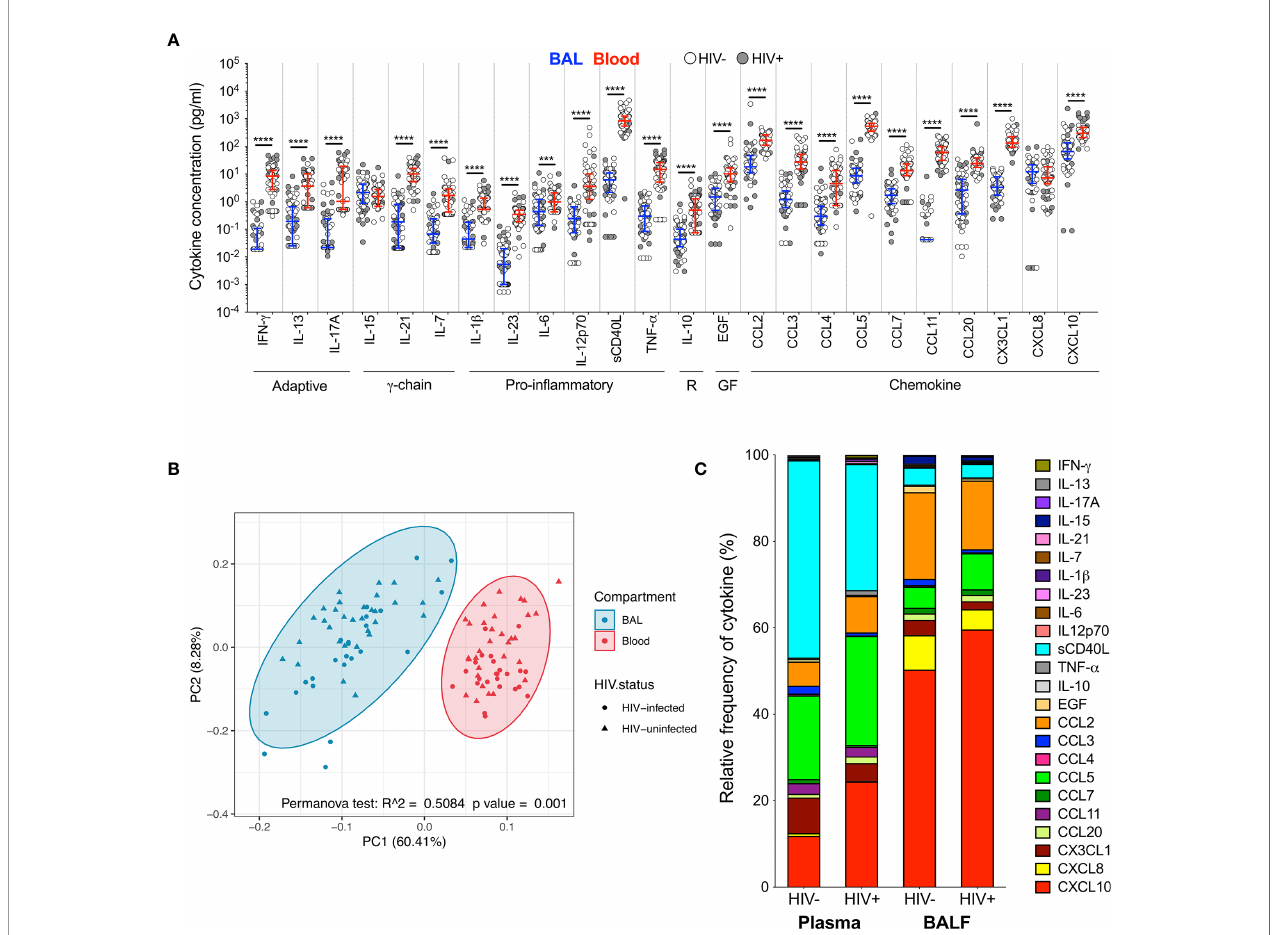
FIGURE 1 | Soluble immune mediators in blood and BAL. (A) Comparison of cytokine concentrations in BAL (blue) and blood (red) of HIV-infected ( fi lled circles) and HIV-uninfected (open circles) individuals. “ R ” refers to regulatory cytokines and “ GF ” refers to growth factors. The blue and red lines denote the median and interquartile ranges for BAL and blood, respectively. Statistical analyses were performed using a non-parametric Wilcoxon paired test with False Discovery Rate (FDR) step down correction. (B) Principal component analysis and permutational multivariate analysis of variance (permANOVA) of cytokine concentrations in BAL (blue) and blood (red). (C) Cytokine concentration expressed as a proportion of the total milieu in BAL and plasma. The relative proportion of each analyte was calculated as a percentage of the sum total of the analyte concentrations in that compartment. GM-CSF, IL-22 and IL-4 were excluded altogether as they were below the level of detection in both BAL and blood. Analytes that fell below the limit of detection for some participants were reported as half the minimum detectable concentration. The p values, p ≤ 0.05, p ≤ 0.01, p ≤ 0.001, p ≤ 0.0001 are reported as *, **, *** and ****,